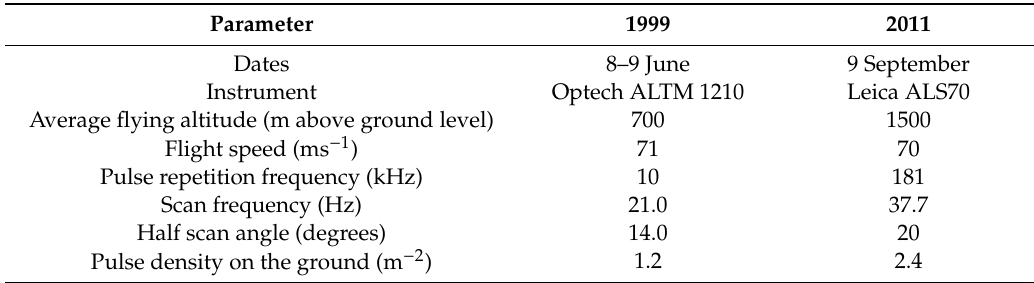
Table 2. Parameters for ALS campaigns in 1999 and